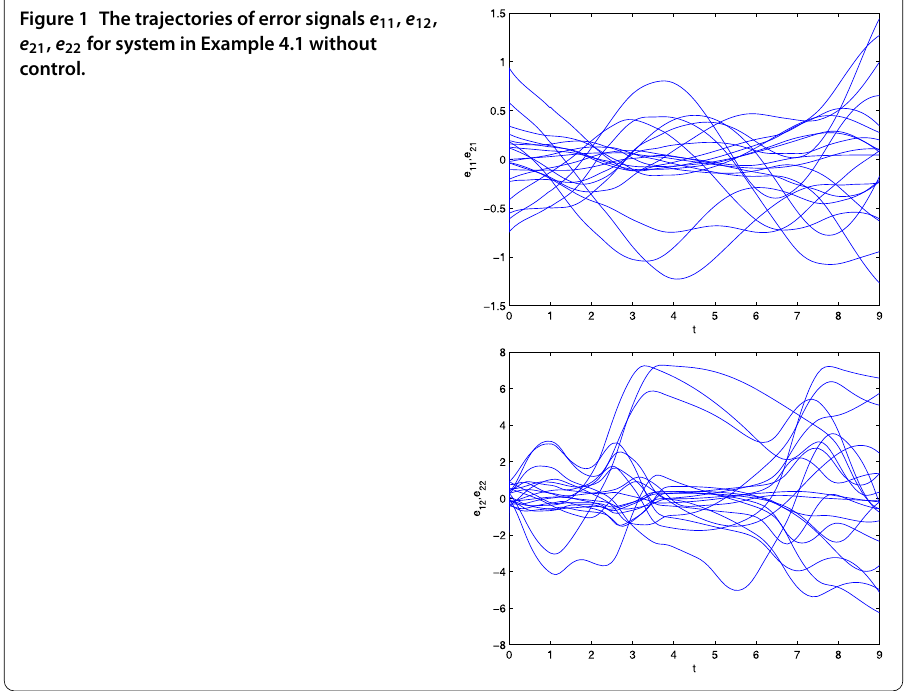
Figure 1 The trajectories of error signals e 11 , e 12 , e 21 , e 22 for system in Example 4.1 without